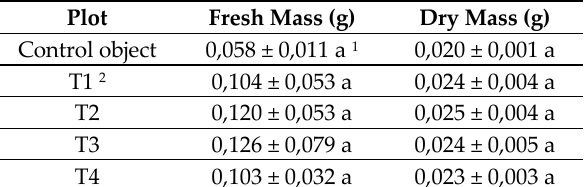
Table 3. Average values and standard deviation for FM and DM.